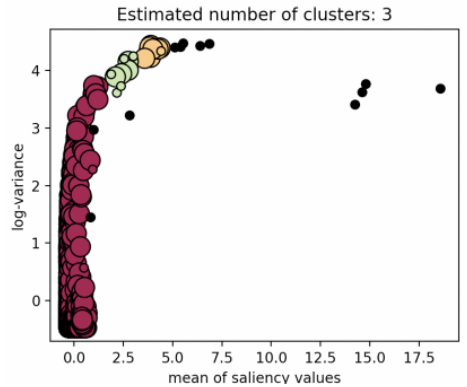
Figure 16. Clustering result by DBSCAN; the red cluster represents the sky region, the clusters with other color are interference